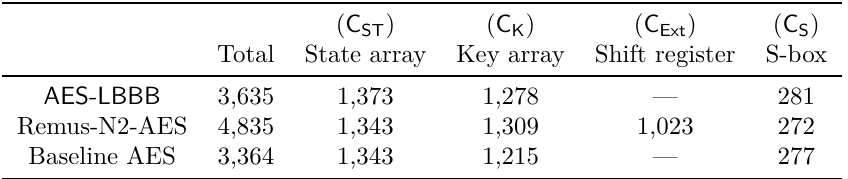
Table 4: Post-synthesis circuit area of AES - LBBB , Remus-N2-AES, and the baseline AES implementation shown in gate equivalent